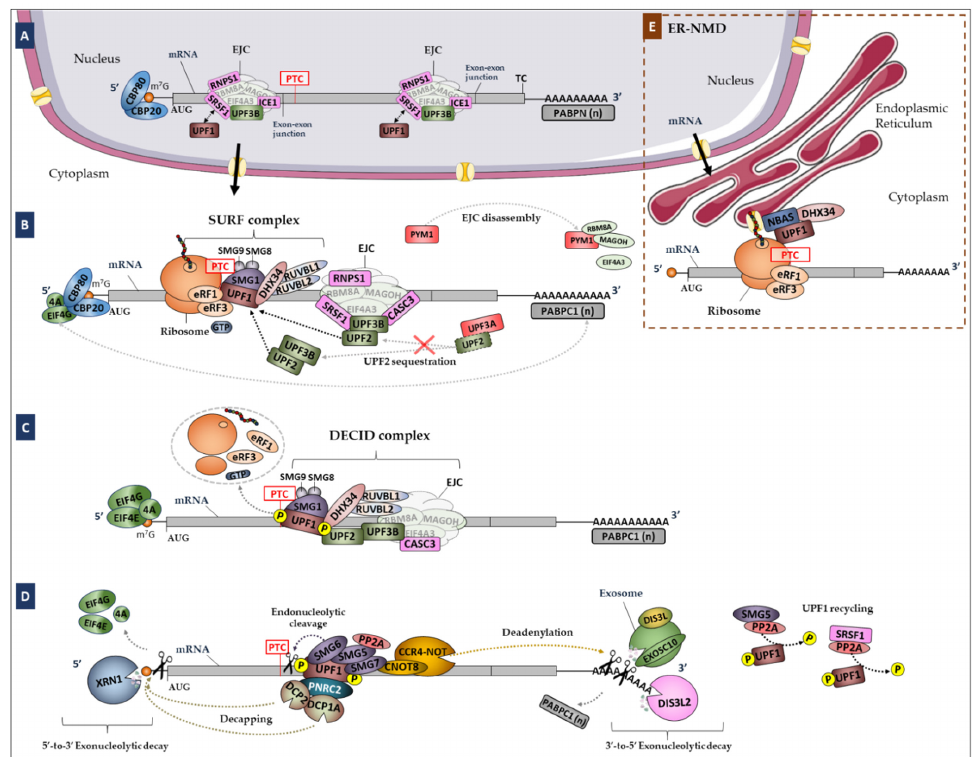
Figure 1. Simplified representation of the NMD pathway in mammalian cells. ( A ) The Exon Junction Complex (EJC; composed by eIF4A3, RBM8A and MAGOH) is formed during splicing and deposited 20–24 nucleotides (nts) upstream of exon–exon junctions, remaining associated with the mRNA during its transport to the cytoplasm. ( B ) In the cytoplasm, the mRNA is translated by the ribosome. If the mRNA carries a premature translation termination codon (PTC), during the pioneer round of translation, i.e., while the mRNA is still bound to the cap binding complex CBP80/20, the ribosome stops at the PTC. If the PTC is located more than 50–54 nts upstream of the last exon–exon junction, the ribosome is not able to displace downstream EJCs. Instead, when the ribosome stops at the PTC, UPF1 can interact with eRF3a, inducing premature translation termination that triggers NMD. For that, the SURF complex is formed by UPF1, eRF1, eRF3a, the SMG1c kinase complex and DHX34 associated with RUVBL1 and RUVBL2. At this stage, both PYM1 and UPF3A can act as NMD repressors. ( C ) UPF2 and UPF3B, either diffused in the cytoplasm (in case of EJC-independent NMD) or bound to the EJC, interact with UPF1, favoring its phosphorylation by SMG1 and the formation of the DECID complex. ( D ) Phosphorylated UPF1 recruits SMG6, which cleaves the mRNA near the PTC, and the SMG5-SMG7 dimer, which recruits the decapping complex DPC2-DCP1a through PNRC2 and the deadenylation complex CCR4-NOT through CNOT8. SRSF1 and SMG5-SMG7 independently recruit PP2A, which dephosphorylates UPF1. NMD-targeted mRNAs are further degraded by 5 ′ -to-3 ′ and 3 ′ -to-5 ′ exonucleolytic activities of XRN1 and the exosome, respectively. ( E ) Model of the ER-NMD pathway. The NMD model was adapted from Nogueira et al., 2021 [29]. Legend: NMD, Nonsense-Mediated mRNA Decay; PTC, Premature Termination Codon; EJC, Exon Junction Complex; SURF, SMG1-UPF1-eRF1-eRF3 complex; DECID, Decay Inducing Complex; PP2A, Protein Phosphatase 2A; ER-NMD, NMD response at the Endoplasmic Reticulum; TC, Termination Codon. 2. Materials and Methods The overall methodology is represented in Figure 2 and is described in detail